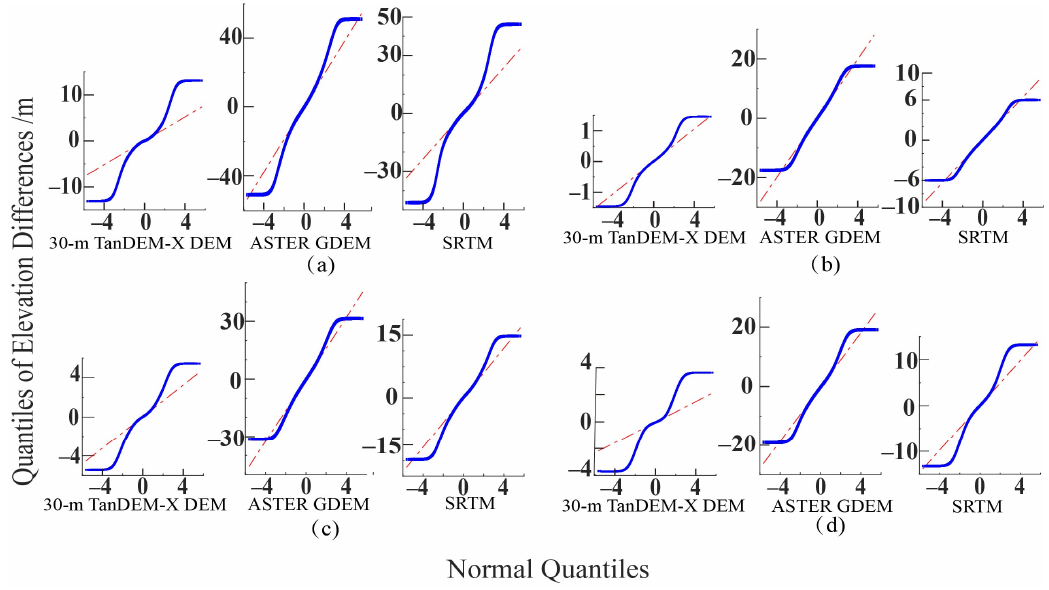
Figure 12. Q-Q plot. The vertical axis is the quantiles of elevation differences between the assessed DEMs and the reference DEM after co-registration in: ( a ) Sichuan; ( b ) Xinjiang A; ( c ) Xinjiang B; and ( d ) Inner Mongolia. The horizontal axis is the normal quantiles. The blue scatters are the observations. The red lines represent a normal distribution.